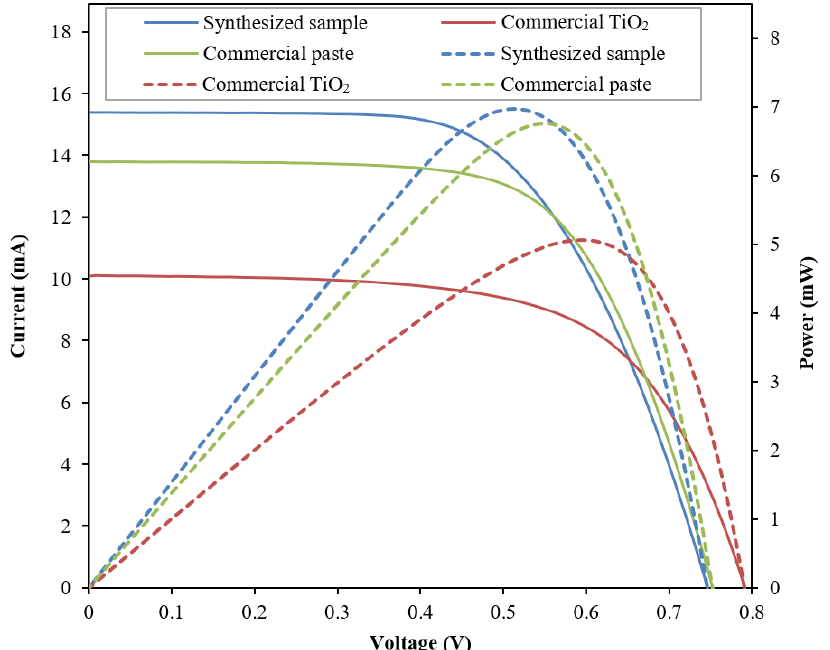
Figure 9. I-V and power plot of the fabricated DSSC integrated with the synthesized sample, the commercial TiO 2 , and the commercial paste as the photoelectrode film. Table 2. Photovoltaic properties of fabricated DSSC integrated with the synthesized sample, the commercial TiO 2 , and the commercial paste as the photoelectrode film.